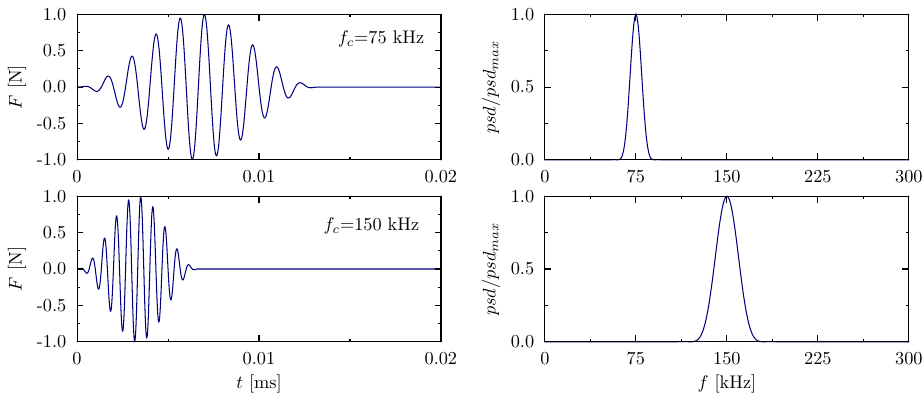
Figure 7. Excitation signals for two different carrier frequencies f c in the time domain ( left ) and their power density spectra in the frequency domain ( right